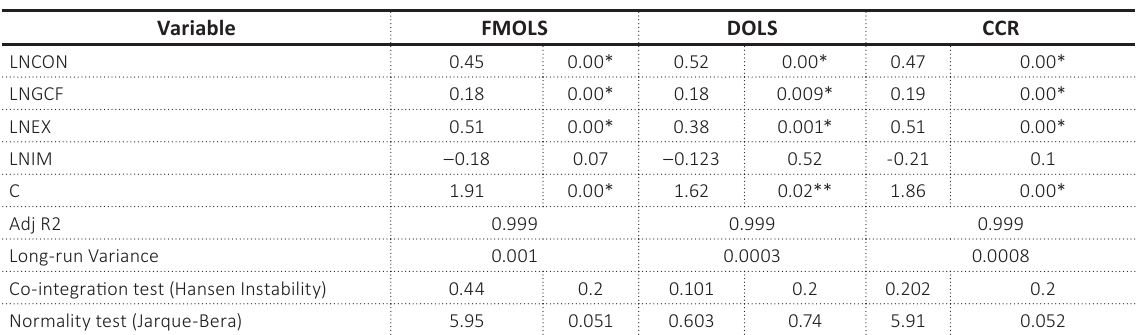
Table 5. Co-integration regression